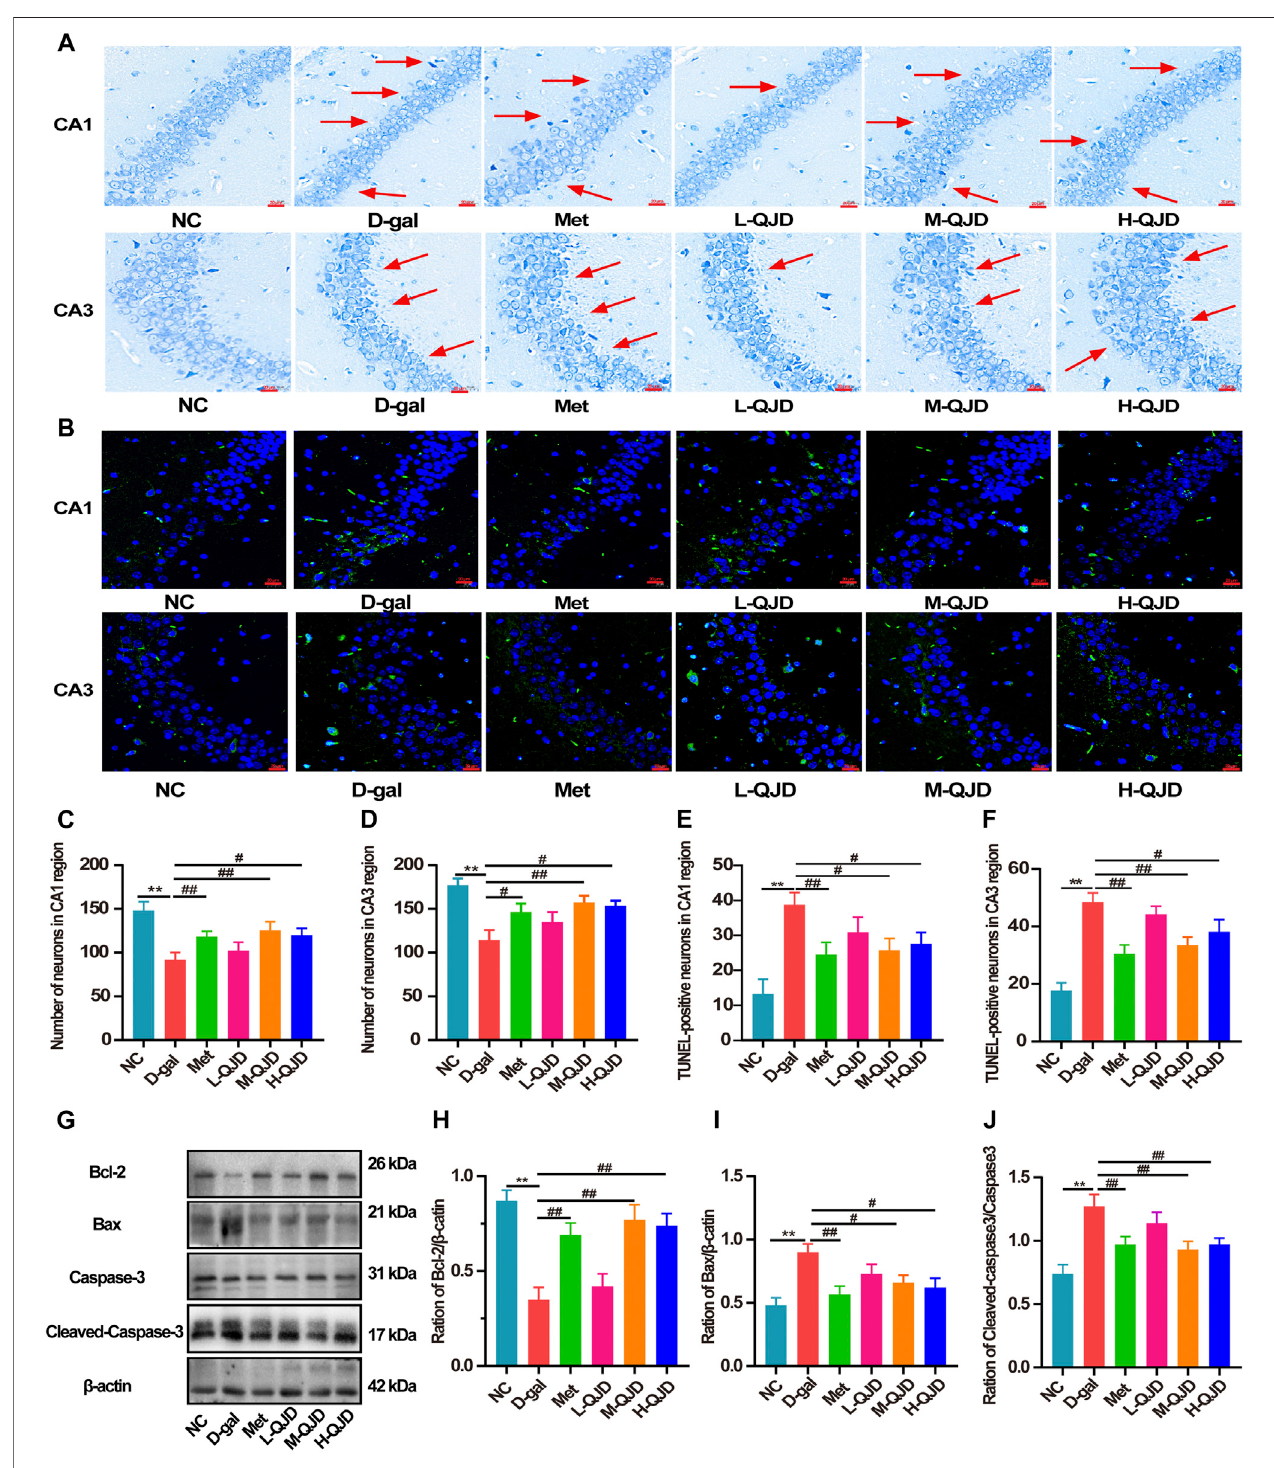
FIGURE 3 | QJD alleviated the hippocampal neuron loss and apoptosis in D-gal – induced mice. (A) Representative Nissl staining images in the hippocampus of CA1 and CA3 regions (magni fi cation × 400; scale bar (cid:1) 20 μ m). (B) Representative TUNEL staining images (labeled in green) in the hippocampus of CA1 and CA3 regions (magni fi cation × 400; scale bar (cid:1) 20 μ m). (C) Number of neurons in the hippocampus CA1 region. (D) Number of neurons in the hippocampus CA3 region. (E) Number of TUNEL-positive neurons in the hippocampus CA1 region. (F) Number of TUNEL-positive neurons in the hippocampus CA3 region. (G) Representative Western blot bands showing the protein expression levels of Bcl-2, Bax, caspase-3 and cleaved caspase-3 in the hippocampus. (H) Relative protein expression level of Bcl-2. (I) RelativeproteinexpressionlevelofBax. (J) Relativeproteinexpressionlevelofcleavedcaspase-3/caspase-3.Theredarrowsindicatethehippocampalneuron loss. All data were presented as mean ± SEM ( n (cid:1) 4 or 6/group). ** p < 0.01 vs. NC group; # p < 0.05 and ## p < 0.01 vs. D-gal group.